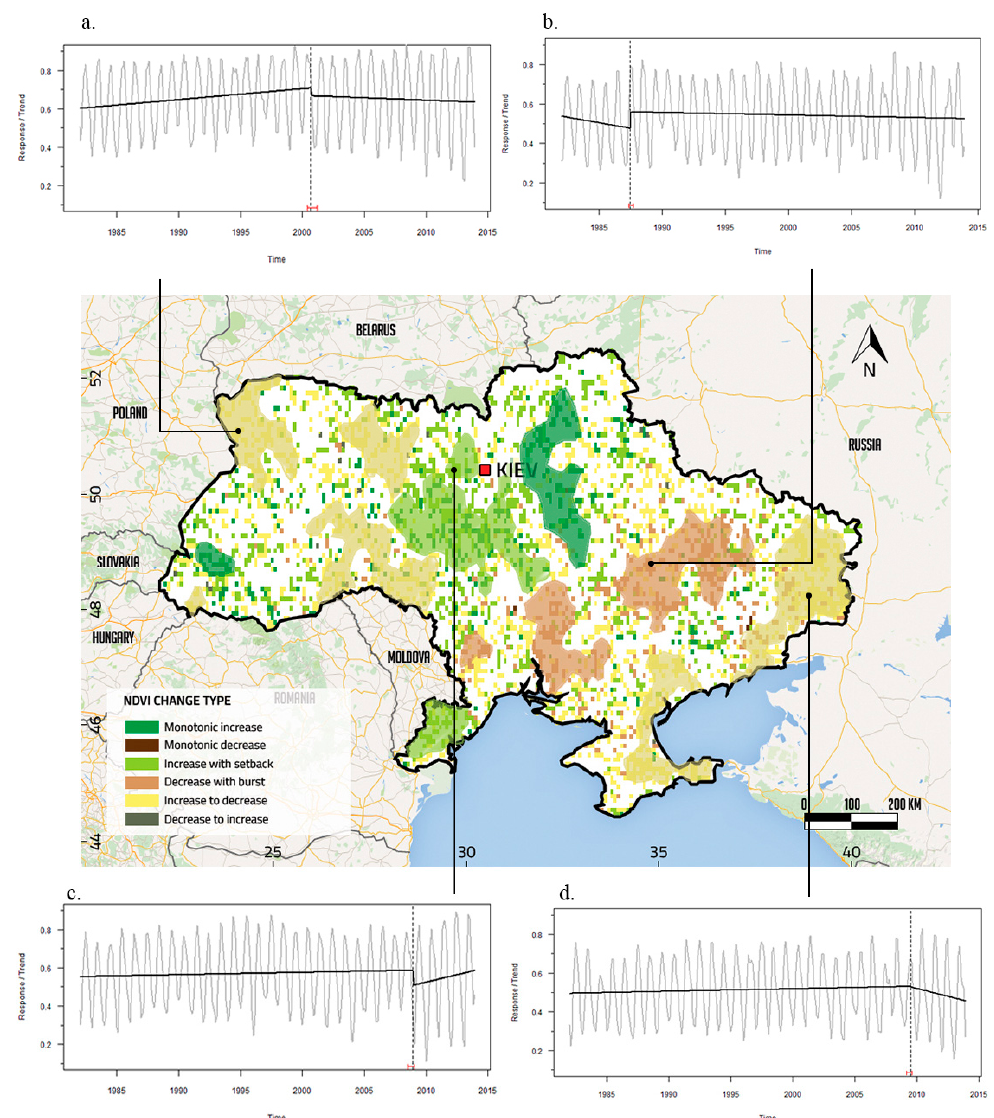
Figure 3. Spatial distribution of the change categories. The pixels with significant trends in both segments and significant monotonic trends are represented ( p < 0.05). Temporal profiles show the most frequent change types. ( a ) Increase to decrease ( b ) Decrease with burst ( c ) Increase with setback ( d ) Increase to decrease. Table 1. Percentage of change types in each land cover class.